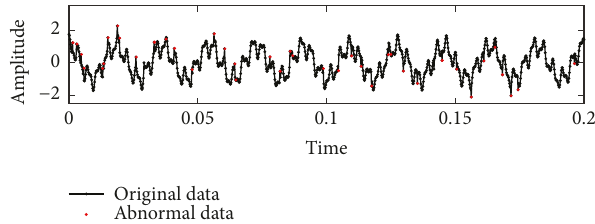
Original data Stacking Figure 10: The time domain diagram of original signal and stacking signal.